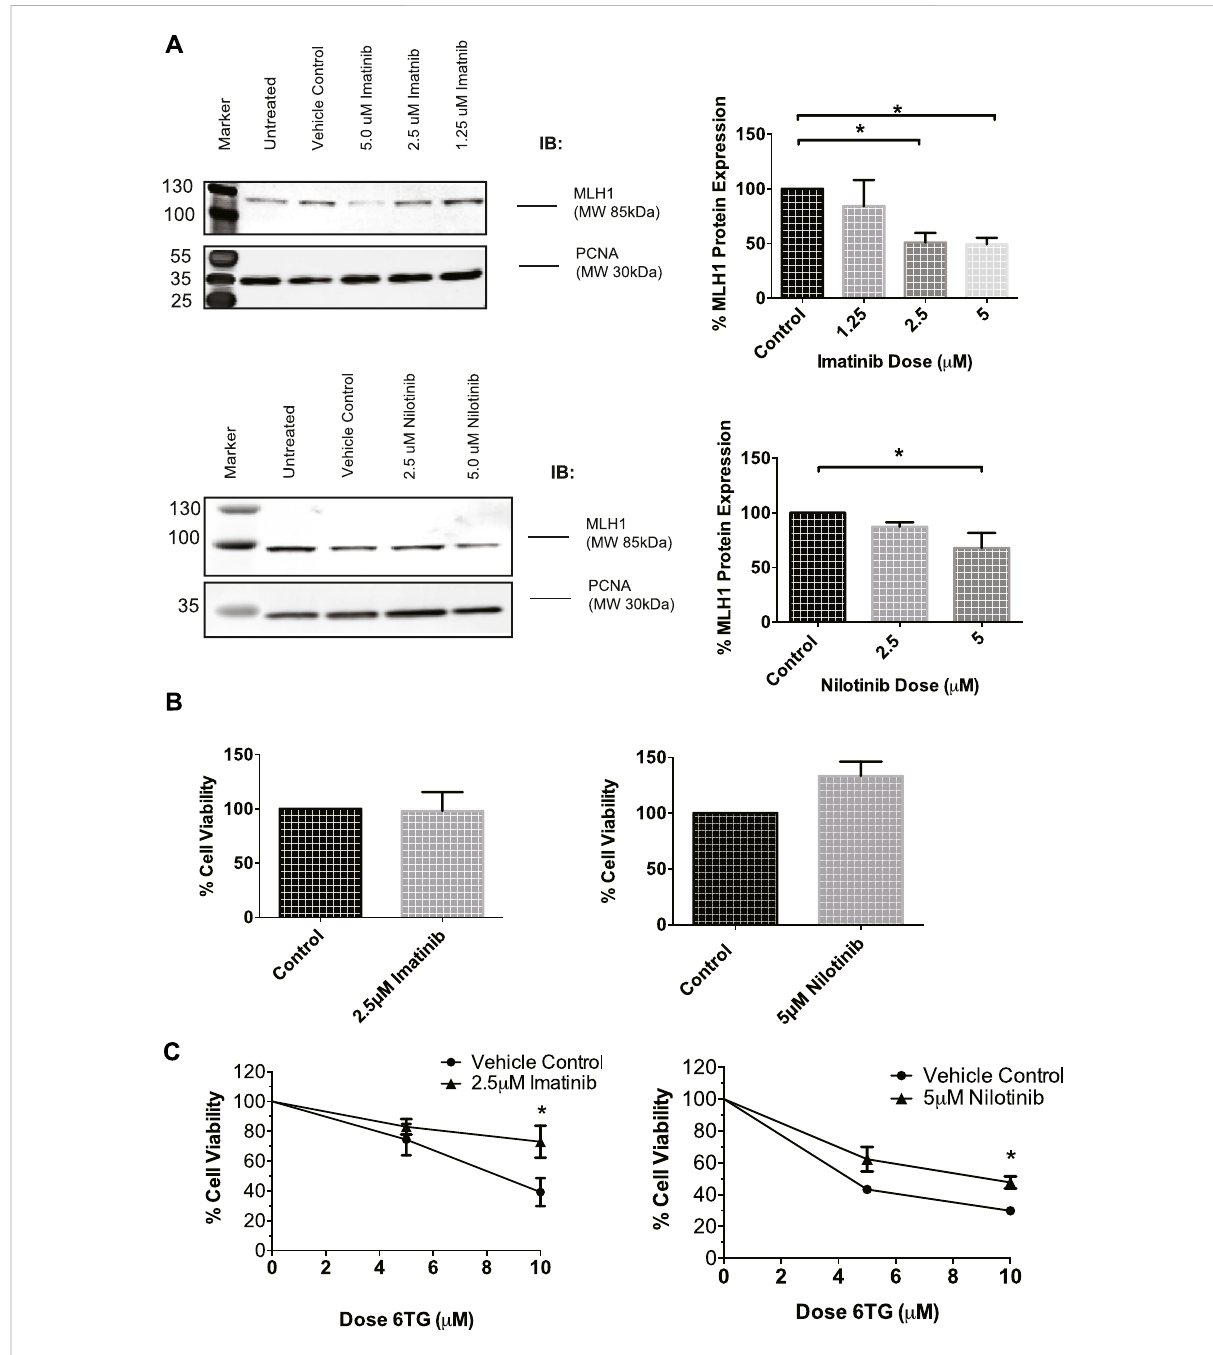
MLH1 protein levels are decreased and MMR function inhibited in HEK293 cells after treatment with tyrosine kinase inhibitors. (A) Western blot analysis and quanti fi cation of MLH1 protein expression after treatment with imatinib (top) and nilotinib (bottom) in HEK293 cells statistical signi fi cance determined by 1-way ANOVA with Bonferroni post-test n = 3 * p < 0.05 (B) Treatment with imatinib or nilotinib alone does not signi fi cantly affect cell viability in HEK293 cells measured via cell count 24 hafter treatment (C) Cellsurvival measured via viable cell count after 48-h co-treatment with imatinib/nilotinib and 6TG, statistical signi fi cance was determined by unpaired t-test n = 3 * p <